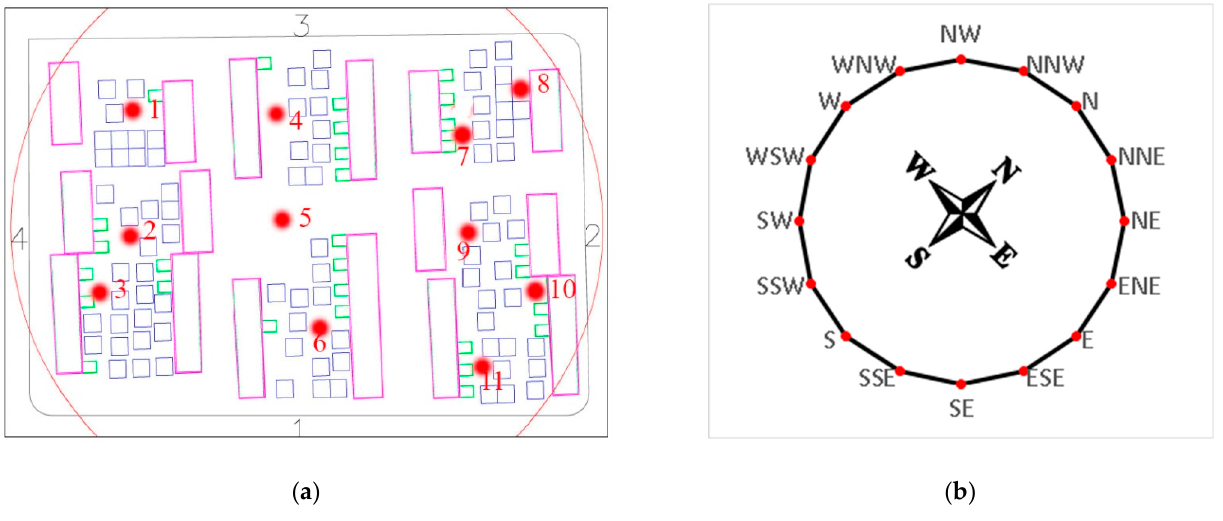
Figure 10. ( a ) Location of the 11 probe points in the wind tunnel to infer the wind flow at three different heights above ground level; ( b ) Sixteen-degree rotating sectors (according to wind rose) for probing the data according to the projection of ( a ).